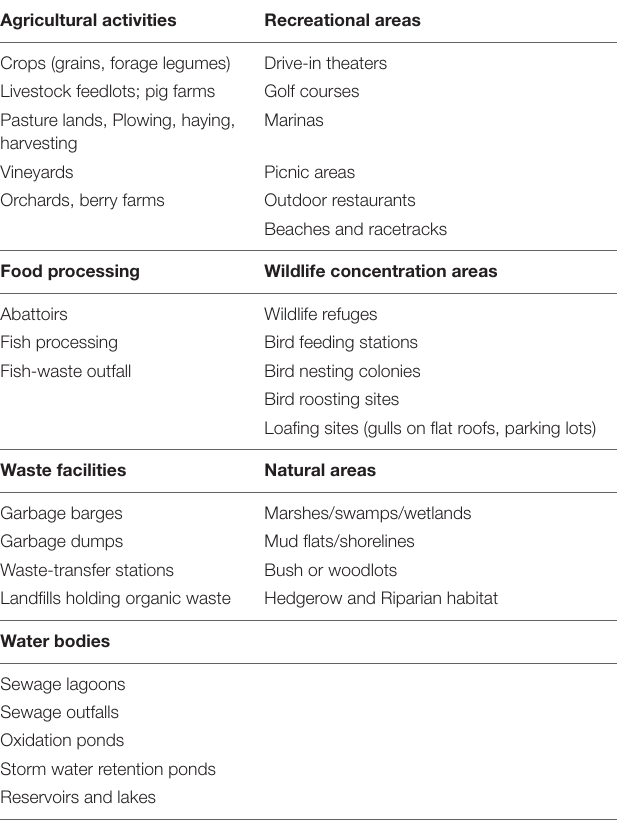
TABLE 1 | Land-uses that create potential bird and wildlife hazards for airports (adapted from the ICAO, 2012). Agricultural